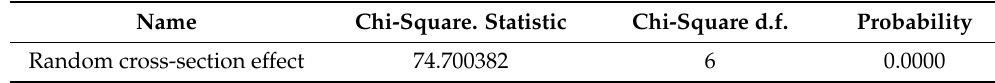
Table 5. Hausman test